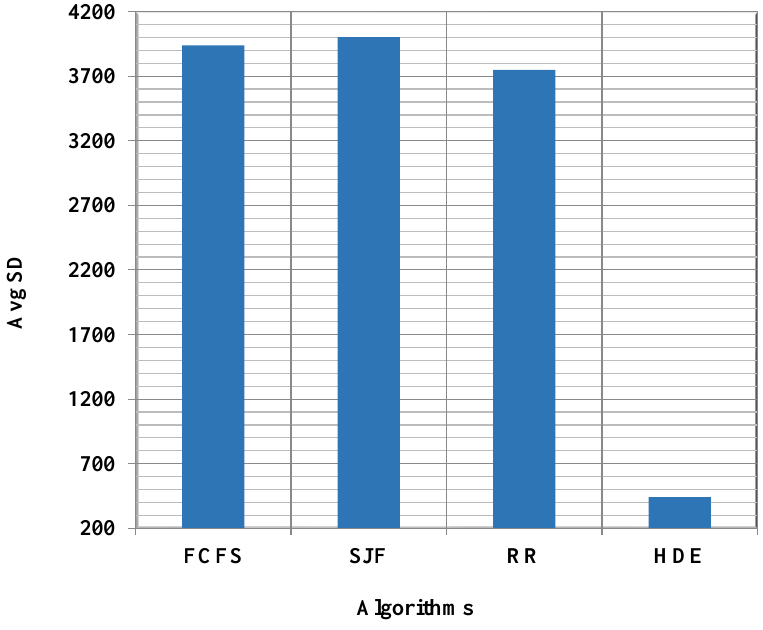
Figure 13. Comparison among algorithms for makespan.